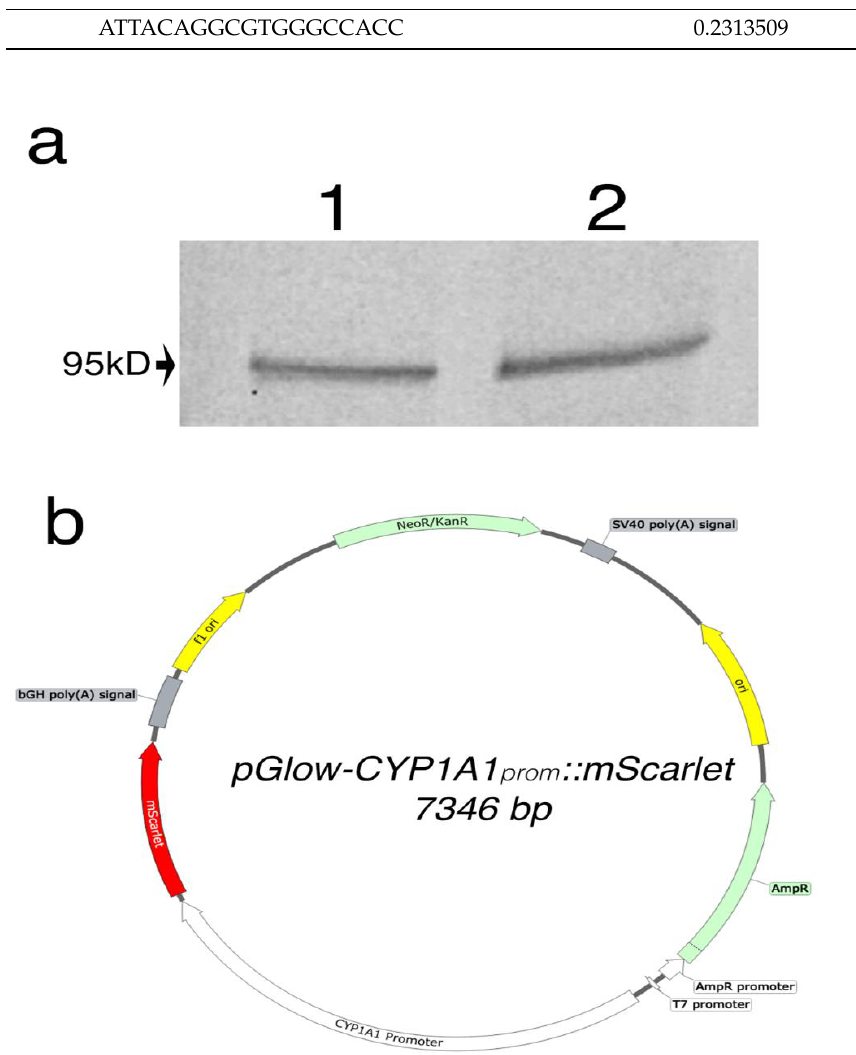
Figure 2. ( a ) Western blot analysis of AHR protein expression in HEK293FT (1) and HeLa (2). A band represents the AHR was observed at 95kD as expected. ( b ) Vector map of pGlow- CYP1A1 prom ::mScarlet plasmid.